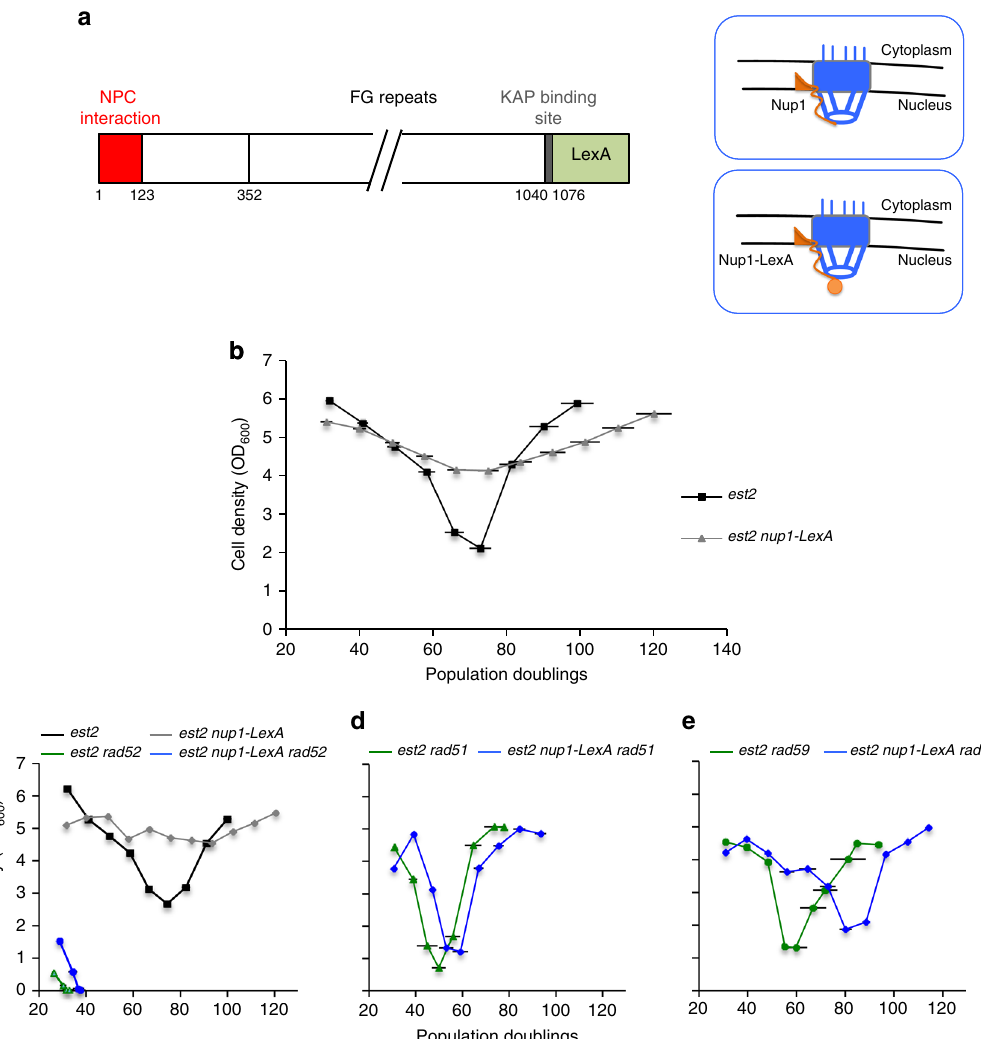
Fig. 1 Attenuation of senescence in est2 Δ nup1-LexA cells. a Schematic structure of the nuclear basket protein Nup1 fused to LexA. b Mean senescence pro fi les of the est2 Δ ( n = 22) and est2 Δ nup1-LexA ( n = 28) clones analyzed in the course of this study. Each clone was isolated by sporulation of a heterozygous diploid strain. Each spore colony was then propagated in liquid culture through daily serial dilutions. OD 600 was measured every day to estimate the cell density reached in 24 h. PD numbers were estimated from the initial spores. c Mean senescence pro fi les of est2 Δ and est2 Δ nup1-LexA clones in the absence of RAD52 ( n = 4 and 8, respectively). Control est2 Δ ( n = 7) and est2 Δ nup1-LexA ( n = 5) curves are from the clones used in this speci fi c experiment. d Mean senescence pro fi les of est2 Δ and est2 Δ nup1-LexA clones in the absence of RAD51 ( n = 4 and 7, respectively). e Mean senescence pro fi les of est2 Δ and est2 Δ nup1-LexA clones in the absence of RAD59 ( n = 4 and 6, respectively). Error bars indicate